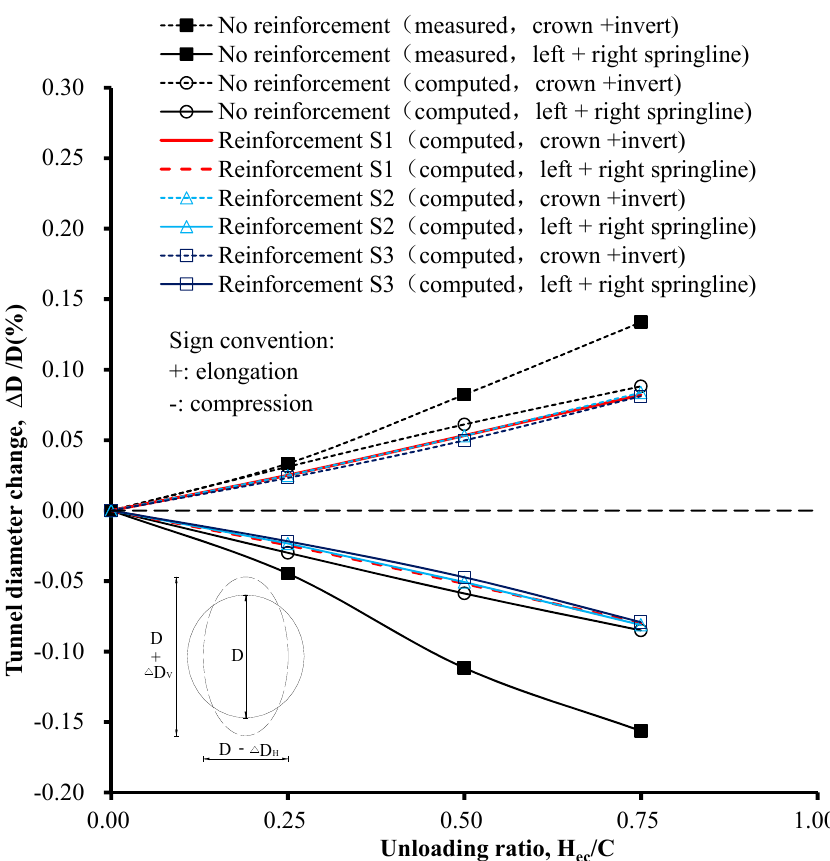
Figure 9. Measured and computed change in tunnel diameter with different soil reinforcement areas.